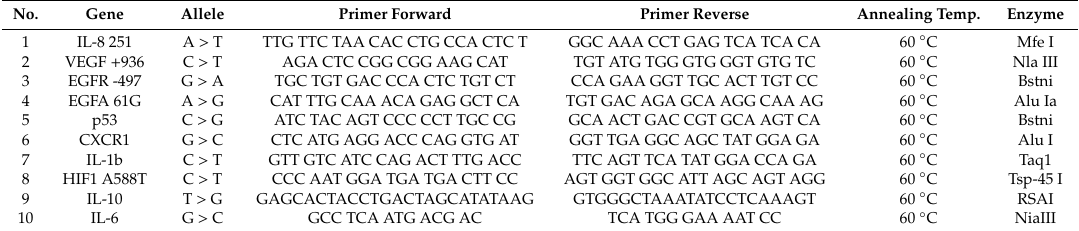
Table 6. Forward and reverse primer sequences and restriction enzymes